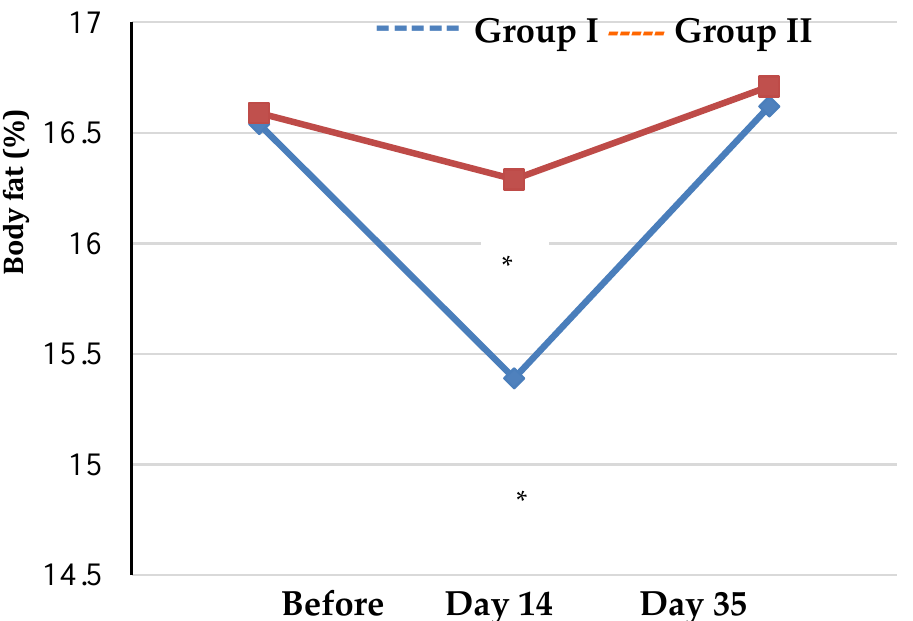
Figure 4. Trends in body fat values of athletes by group (* p < 0.05—statistical significance of differences compared to the baseline).